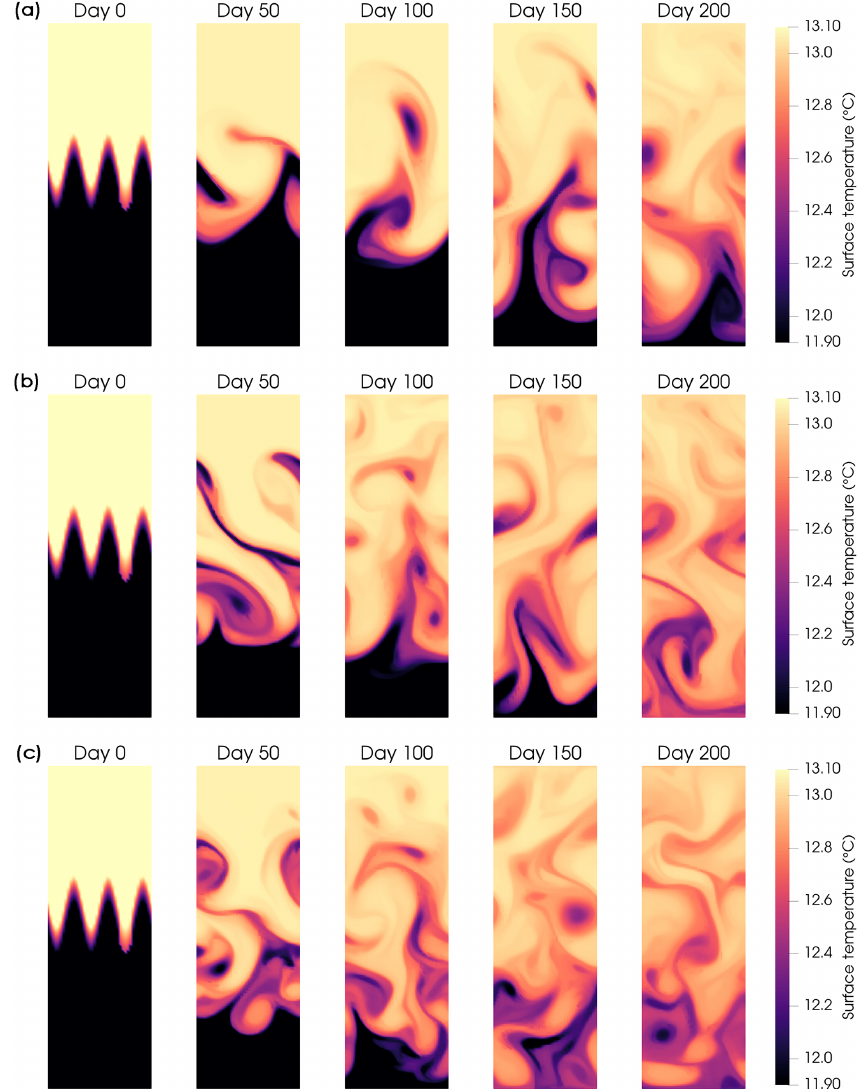
Figure 5. Sea surface temperature fields for the eddying channel test case at 4km horizontal mesh resolution. Horizontal viscosity is 200 (a) , 50 (b) , and 20m 2 s − 1 (c) . These values correspond to mesh Reynolds numbers 2, 8, and 20,